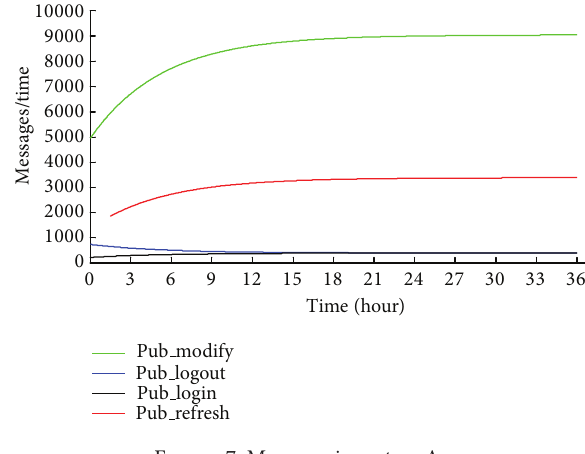
Figure 7: Messages in system